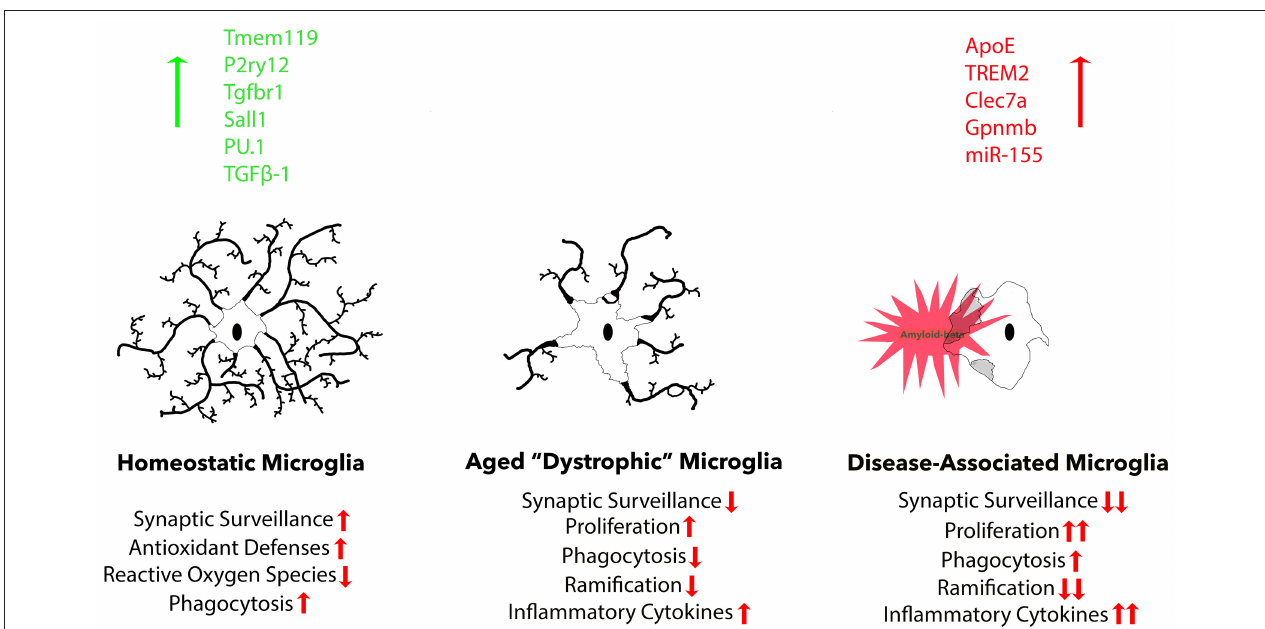
FIGURE 2 | Three common microglia phenotypes are described. Homeostatic microglia are found in the adult brain under non-infectious, non-diseased, and non-aged conditions, exhibiting robust expression of homeostatic microglial markers: Tmem119, P2ry12, Tgfbr1, and transcription factor Sall1. During normal aging, homeostatic markers gradually decline, resulting in reduced functional aspects, including proliferation, phagocytosis, ramification, and cytokine secretion. Finally, there is a distinct microglia phenotype that is associated with neurodegeneration that possesses a more exacerbated dystrophic phenotype, but is specifically associated with plaques and dystrophic neurites that cause